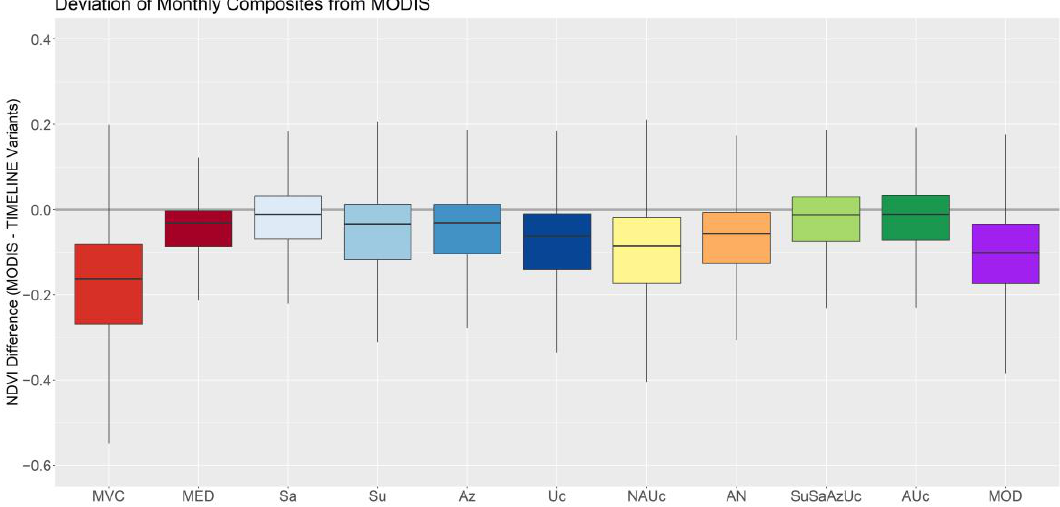
Figure 6. Deviation of the monthly composites generated with compositing approaches from MODIS NDVI for the entire TIMELINE area.